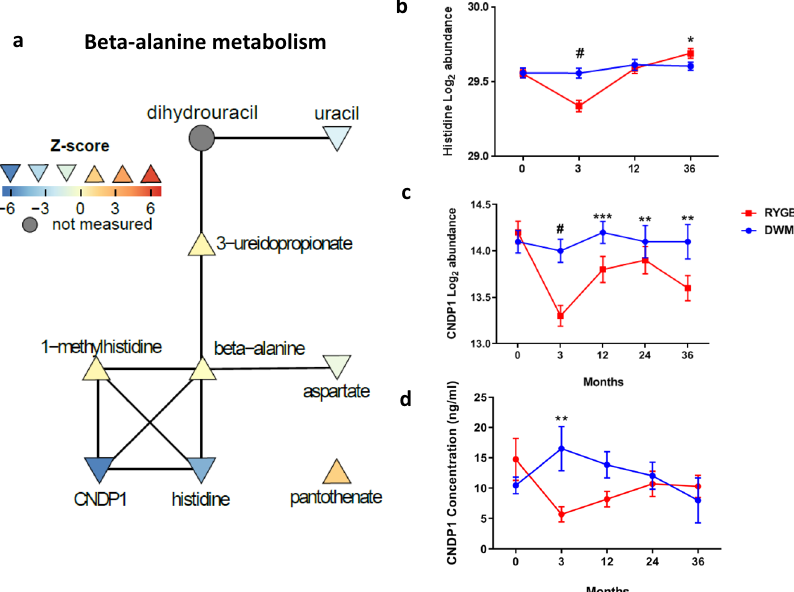
Fig. 5 Beta-alanine metabolism. a Network nodes are colored by between-group z-score, whereas unmeasured nodes are colored gray. Orientation of triangle also indicates the directionality of regulation. Connections are from the Pathway Commons network. b Log 2 abundance of histidine measured by metabolomics in samples from independent human participants at baseline, 3, 12, and 36 months from 19, 18, 16, and 9 DWM and 19, 18, 19, and 13 RYGB participants. c Log 2 abundance of CNDP1 measured by SOMAscan, measured in samples from independent human participants at baseline, 3, 12, 24, and 36 months from 19, 19, 16, 10, and 9 DWM and 19, 19,19, 15, and 14 RYGB participants. d CNDP1 plasma levels measured by ELISA at baseline, 3, 12, 24, and 36 months from 10, 10, 10, 6, and 4 DWM participants and 10, 10, 9, 5, and 6 RYGB participants, respectively. Data were analyzed by two-sided moderated t-tests; post-baseline time points were analyzed using change from baseline. Data in b − d are reported as mean ± SEM. Nominal p -values are as follows: b histidine: 3 mo: #<0.0001, 36 mo: * = 0.019; c CNDP1 (SOMAscan): 3 mo: #<0.0001, 12 mo: *** = 0.00014; 24 mo: ** = 0.0054; 36 mo: ** = 0.0067;